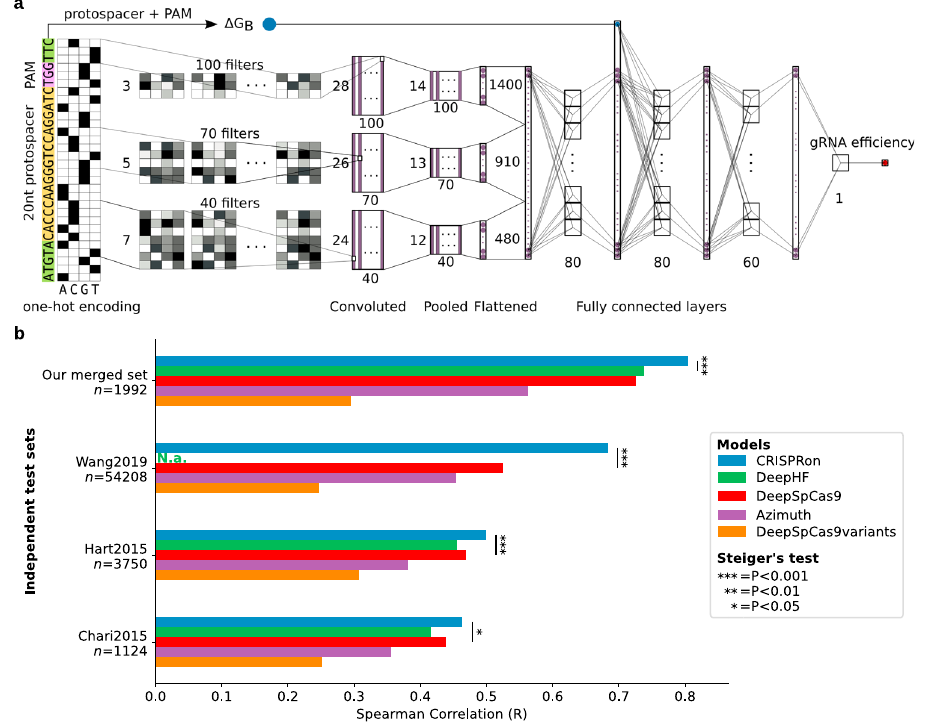
Fig. 2 The CRISPRon model and generalization ability on independent test sets. a Schematic representation of the CRISPRon input DNA sequence and prediction algorithm. The inputs to the deep learning network are the one-hot encoded 30mer and the binding energy ( Δ G B ). Note that only the fi ltering (convolutional) layers and the 3 fully connected layers are shown explicitly and that the thin vertical bars are the output of one layer, which serves as input for the next layer. b Performance comparison between CRISPRon and other existing models on independent test sets larger than 1000 gRNAs. N.a. not available (all gRNAs were regarded as training data due to lack of explicit train-test separation). CRISPRon_v0 was employed for testing on the internal independent test set ( “ Our merged set ” , including gRNAs from both our study and Kim et al. (2019)). CRISPRon_v1, or simply CRISPRon, was used for the external independent test sets (for a description of the CRISPRon versions, see Supplementary Table 1). The two-sided Steiger ’ s test P -values of all comparisons are reported in Supplementary Data